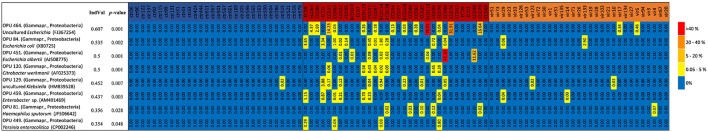
Heatmap of indicative species in the DEC group. Distribution of indicative species according their relative abundance in each sample. Healthy group (blue), DEC group (red), and viral group (green).